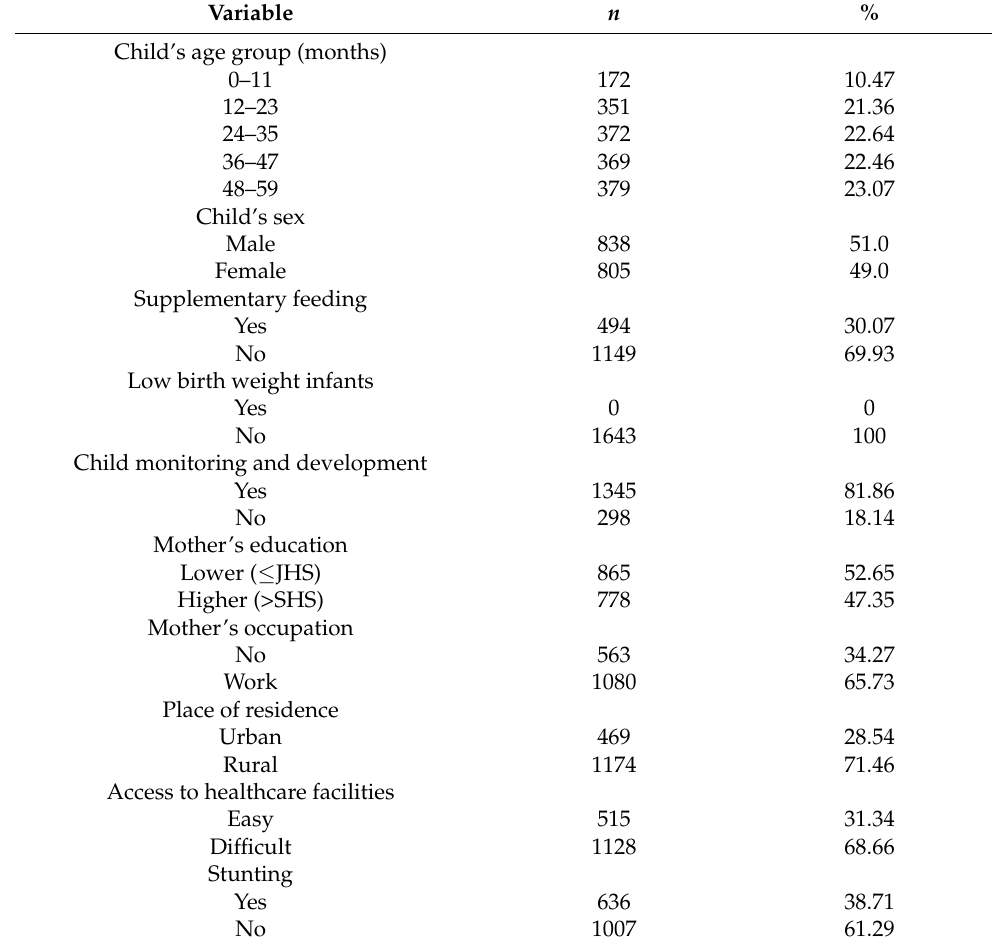
Table 1. Frequency distribution of respondents by characteristics (N =